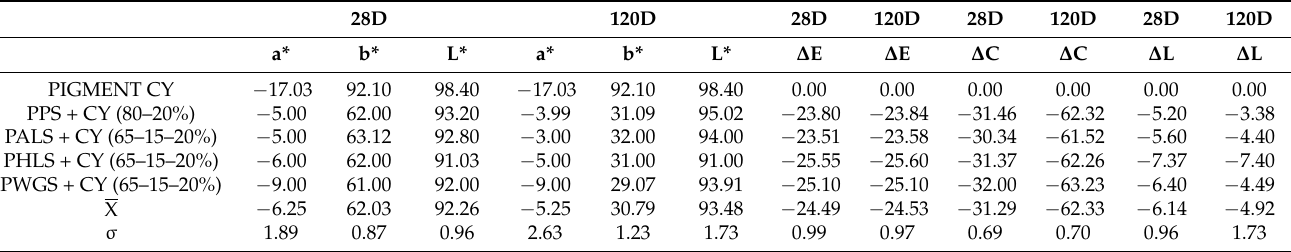
Table 8. CIELab* 1976 values for the pigments and pastes used in this study and total color variations ( ∆ E), chromaticity variations ( ∆ C) and luminosity variations ( ∆ L) of the pigments used in the preparation of the pastes after 28 and 120